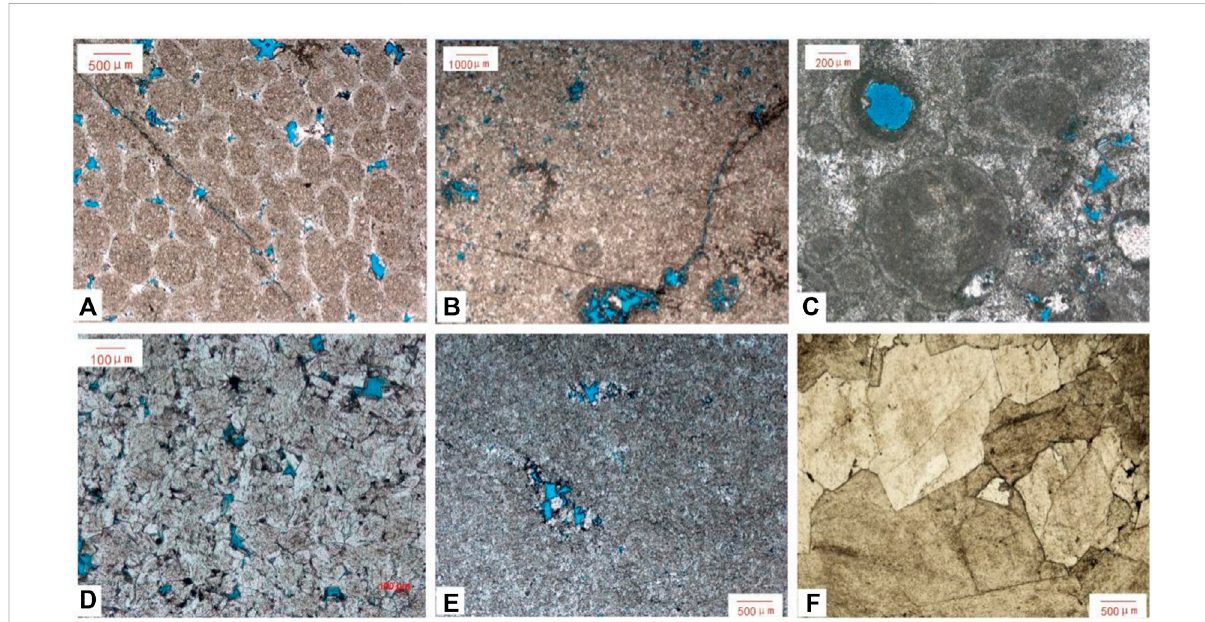
FIGURE 2 Developmentcharacteristics ofdifferentpore types intheLongwangmiao Formation inthestudy area. (A) Intergranular dissolved pores, oolitic dolomite, Well GS6, 4546.25, single polarized light; (B) Intergranular and intragranular dissolved pores, sandy dolomite, 4662.5 m, Well GS23, single polarized light; (C) Mold pore, sand dolomite, well GS7, 4635.55 m, single polarized light; (D) Intercrystalline pores and intercrystalline dissolved pores, sugar-like fi ne-crystalline dolomite, Well GS11, 4571.57 m, single polarized light; (E) Intercrystalline dissolved pores, powder crystal dolomite, Well GS11, 4584.22 m, single polarized light; (F) Intracrystalline dissolved pores, giant crystal dolomite, well MX12, 4637.41 – 4637.84 m, single polarized